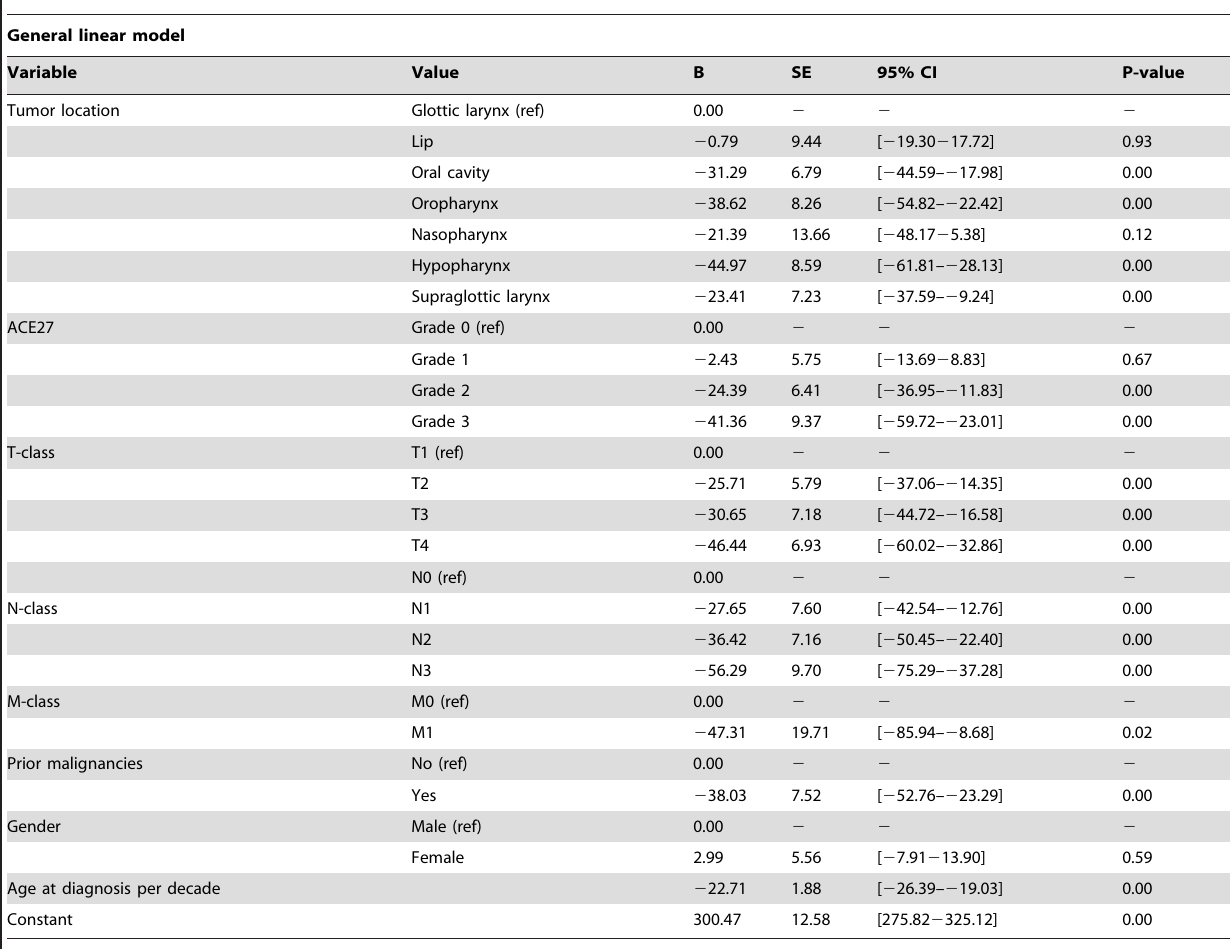
Table 9. General linear model for the outcome ‘estimated survival time’.